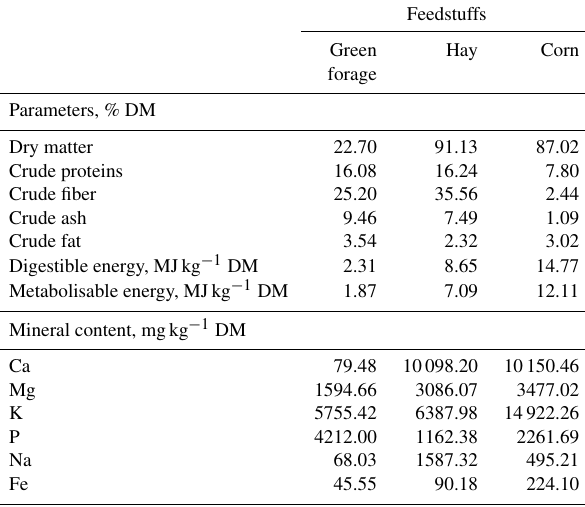
Table 1. Chemical composition of ingredients in goats’ diets.